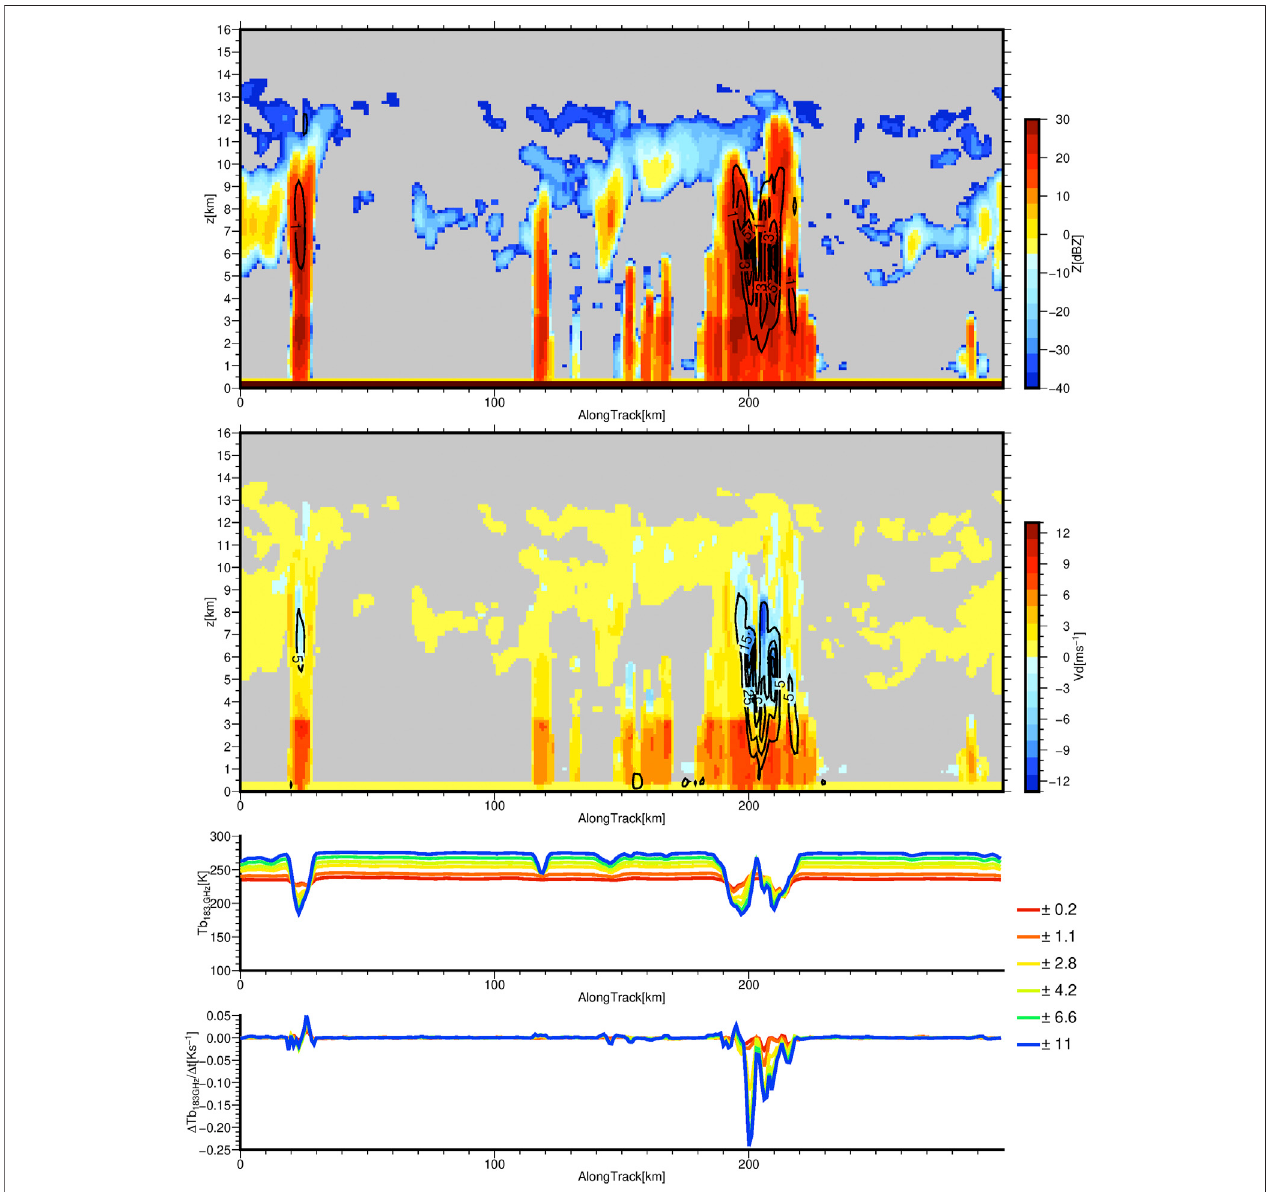
top panels as contour levels. The two lower panels show the Tbs and dTb/dt of the six channels sampling the 183.31 GHz line.